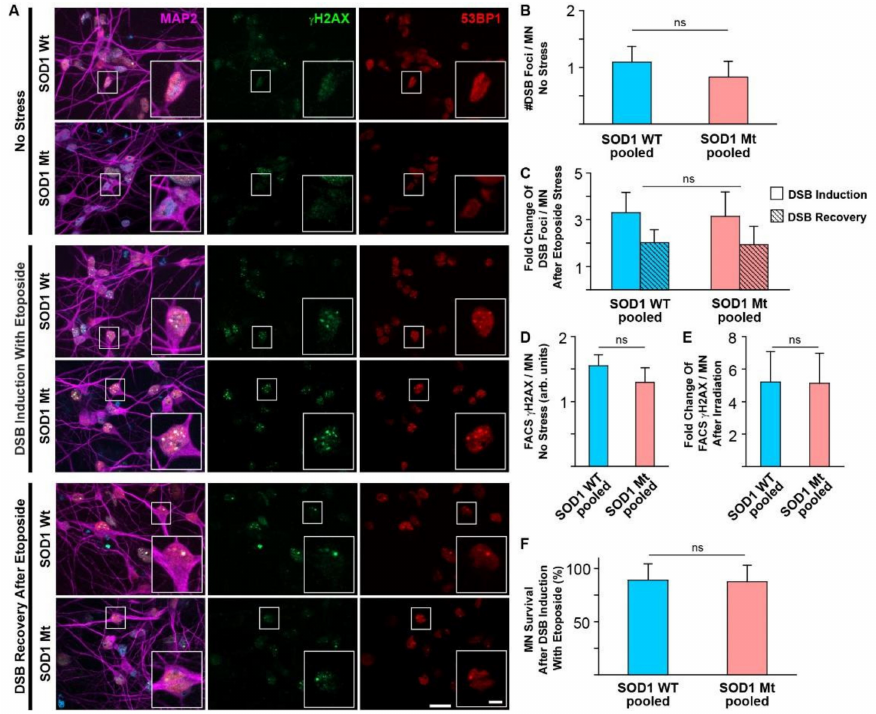
Figure 3. DNA damage is not increased in SOD1 Mt MNs. DNA double strand breaks (DSBs) detected with anti- γ H2AX and anti-53BP1 were indistinguishable in unstressed SOD Wt versus Mt ( A row 1–2, B ) or neither after induction of DSBs through 1 h treatment with 2 µ M etoposide ( A row 3–4, C ) nor after 24 h-recovery after DSB induction with 5 µ M etoposide ( A row 5–6, C ) in MAP2—positive human MNs. Similar results were observed using FACS analysis of γ H2AX in MNs without stress and after DSB induction by X-ray irradiation with 2 Gy ( D , E ). Cell survival ( F ) was not affected by DNA damage induction with 2 µ M etoposide in neither SOD1 Wt nor SOD1 Mt. SOD1 WT in image galleries ( A ): shown are representative examples of Ctrl1 (Table 1). SOD1 Mt in image galleries ( A ): shown are representative examples of D90A (Table 1). SOD WT pooled: data from Ctrl1 and Ctrl2 ( B , C , F ) or Ctrl2, Ctrl3 and Ctrl4 ( D ) were pooled (Table 1), SOD Mt pooled: data from R115G, A4V and D90A ( B – D , F ) (Table 1). Three ( B , C , F ) and four ( D ) independent biological replicates for each cell line and each condition. N.s.: no significant change in unpaired two-tailed Student’s t -test. Scale bar = 20 µ m, in inlet = 5 µ